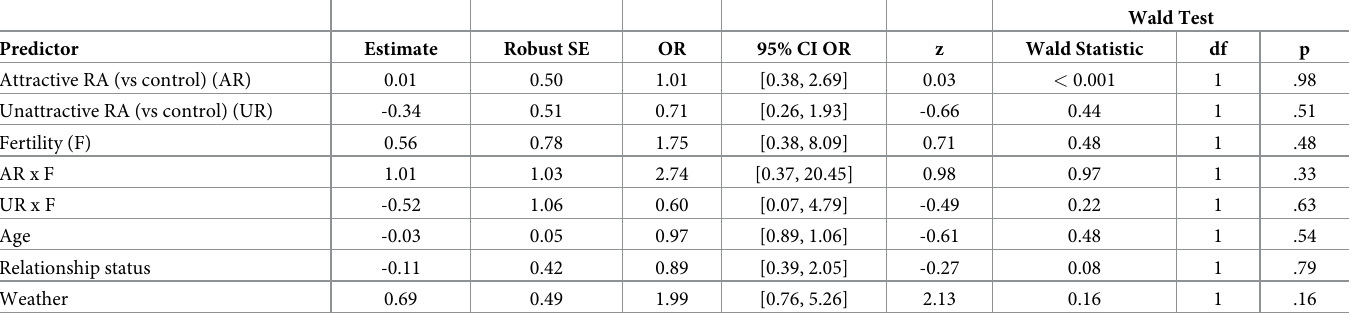
Table 2. Regressing the likelihood of wearing red (0: no vs 1: yes) from the attractiveness of the research assistant, fertility, attractiveness x fertility interaction, con- trolling for age, relationship status and weather for normally cycling participants. Predictor